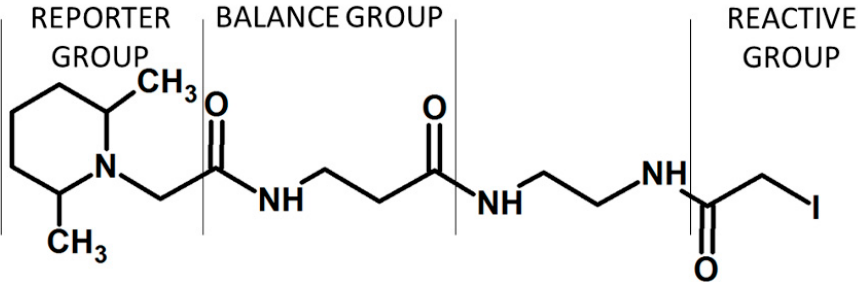
Figure 10. The iodoTMT reagent for cystein-containing peptide labeling and quantification proposed by Pan and co-workers [46].